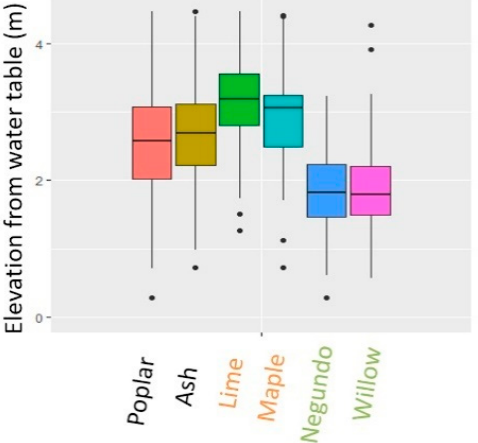
Figure 8. Ranges of relative elevation at which certain species were present in the forest plots of the ONF survey, considering only forest plots older than 50 years.